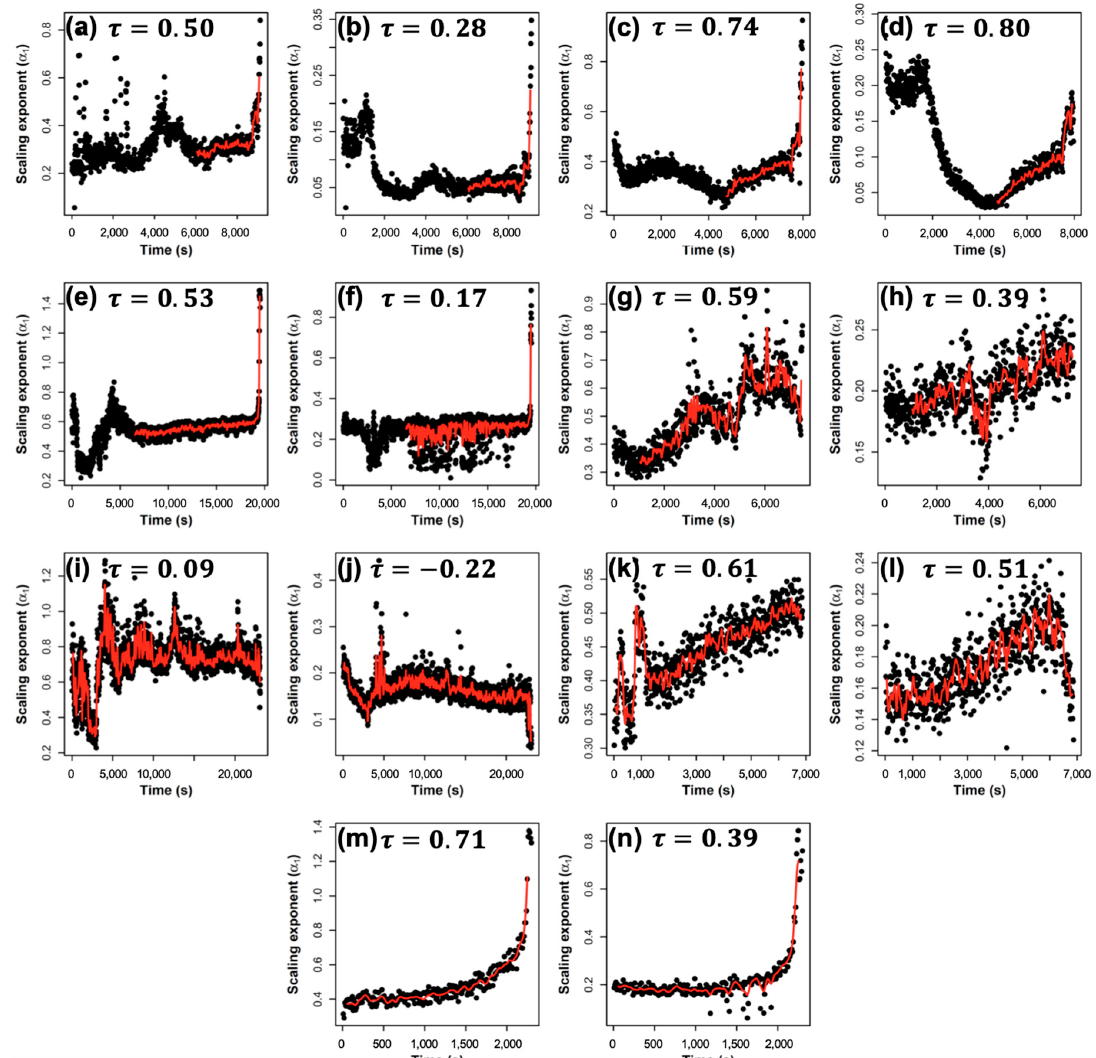
Figure 10. The scaling exponents ( α 1 ) of non-overlapping 2560-sample segments of the vibration signals toward bearing failure: ( a ) data set 2_1 (horizontal); ( b ) data set 2_1 (vertical); ( c ) data set 2_2 (horizontal); ( d ) data set 2_2 (vertical); ( e ) data set 2_3 (horizontal); ( f ) data set 2_3 (vertical); ( g ) data set 2_4 (horizontal); ( h ) data set 2_4 (vertical); ( i ) data set 2_5 (horizontal); ( j ) data set 2_5 (vertical); ( k ) data set 2_6 (horizontal); ( l ) data set 2_6 (vertical); ( m ) data set 2_7 (horizontal); ( n ) data set 2_7 (vertical).